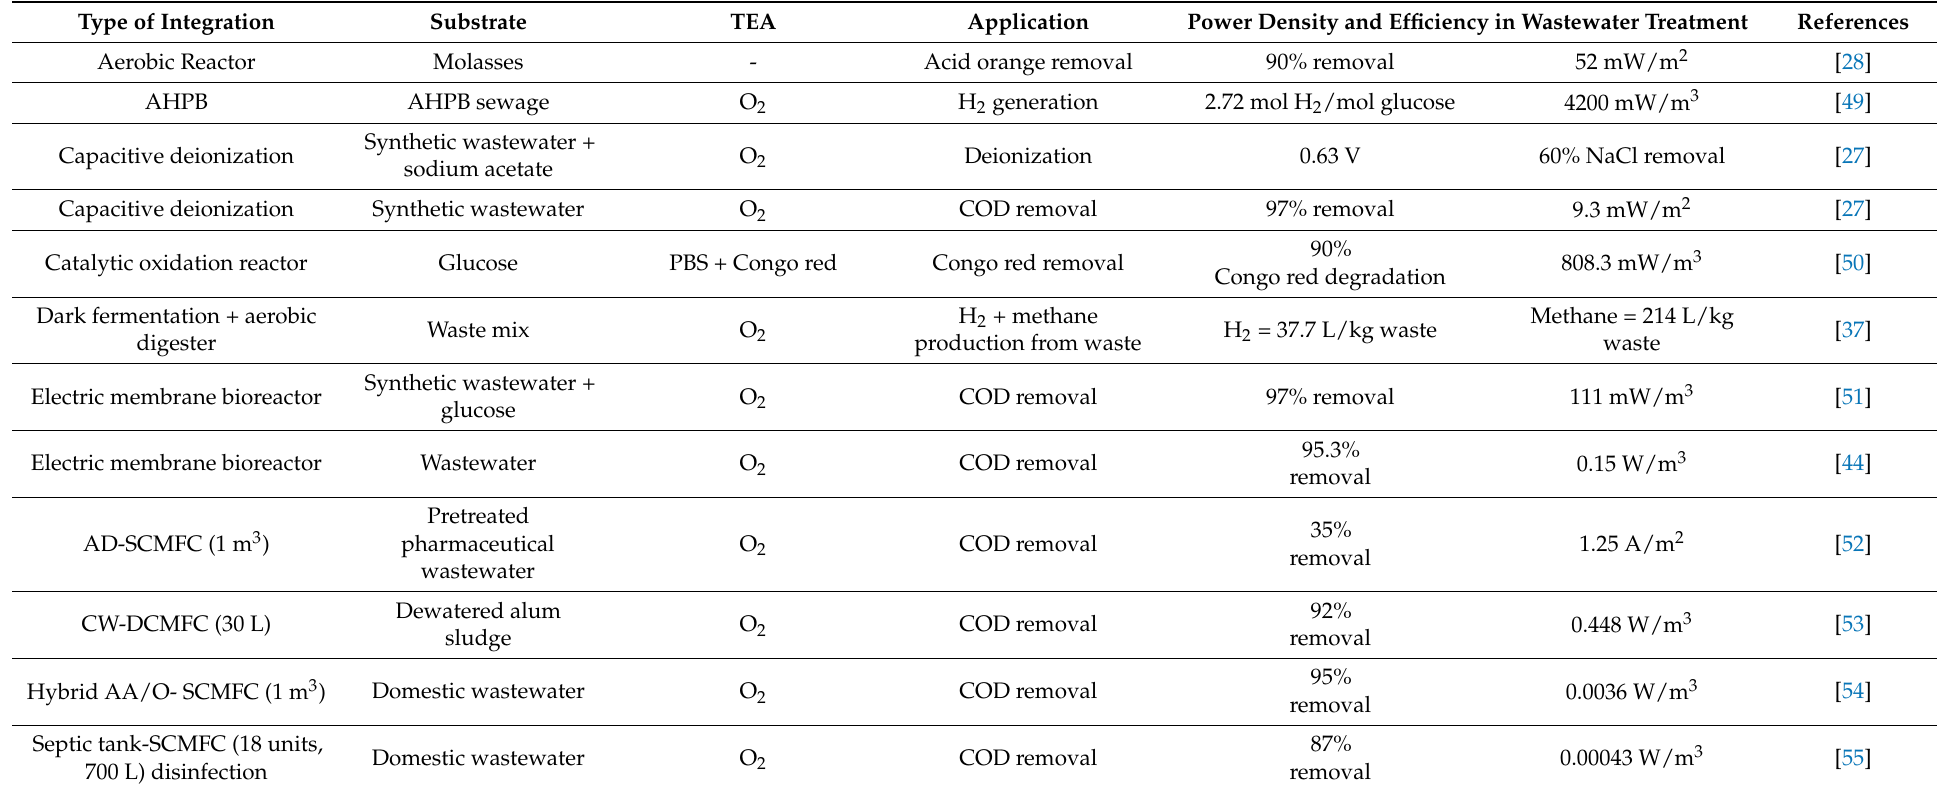
Table 1. Integrated systems of microbial fuel cells (MFCs) with various